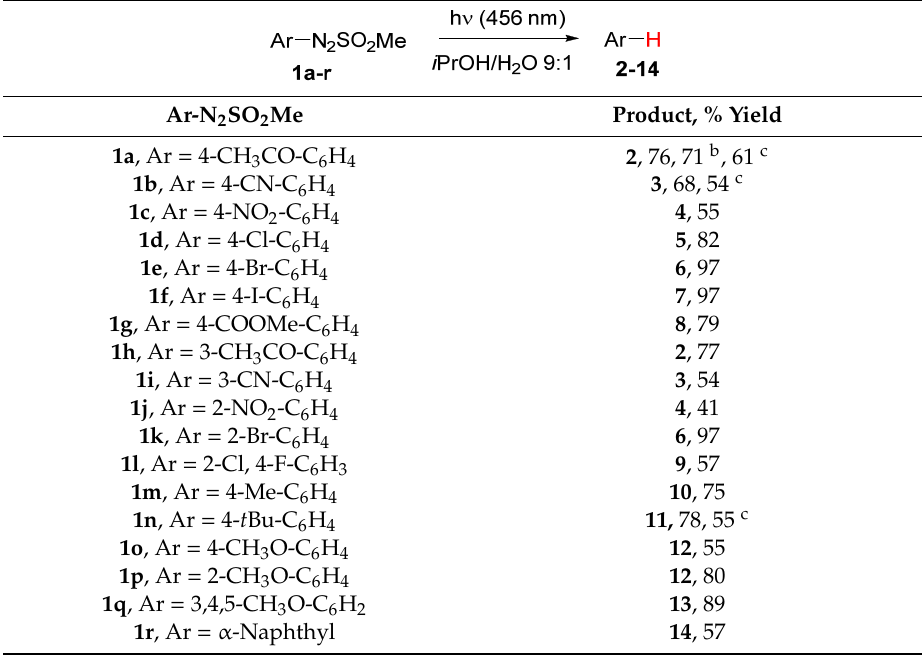
Table 1. Reductive dediazoniation of arylazo sulfones. Substrate scope a .